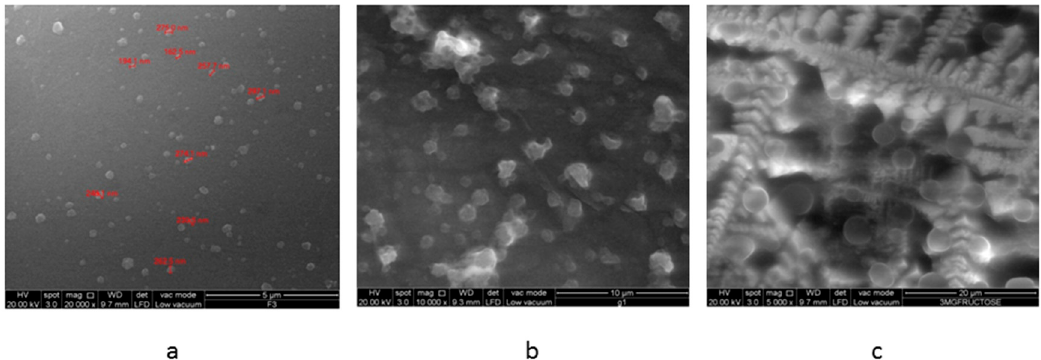
Figure 7. FESEM images of freeze-dried samples of ( a ) freshly prepared F3PN nanoparticulate formulation; ( b ) after exposure to 3 mg/mL glucose; and ( c ) after exposure to 3 mg/mL fructose.